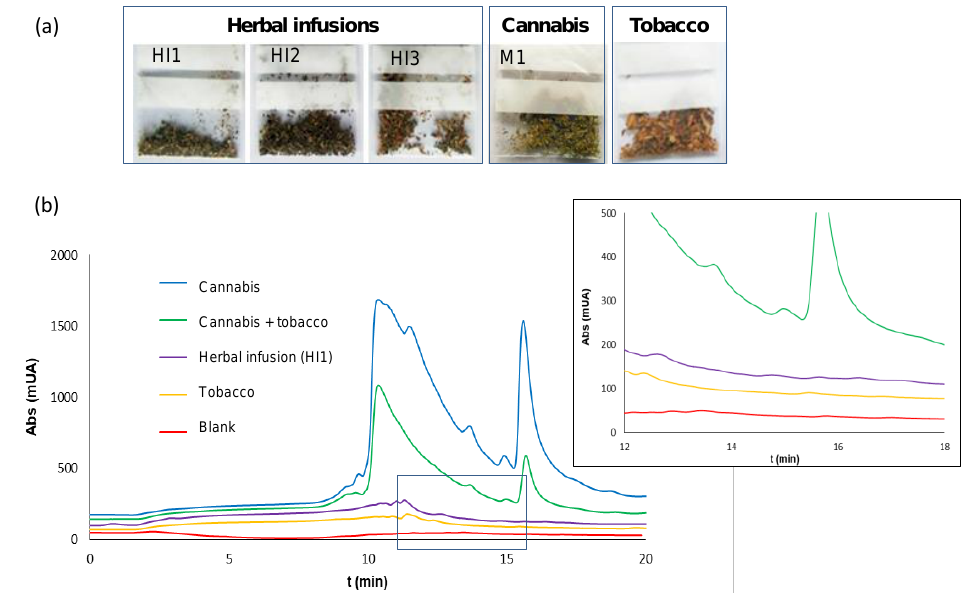
Figure 5. ( a ) Images of the bags with the different products used in the selectivity study: herbal infusions (HI1–HI3), tobacco, and cannabis (M1). ( b ) Chromatograms obtained for the analysis of residues collected from some of the bags ( a ) after the removal of the products: cannabis (M1), tobacco, a mixture of M1 and tobacco (1:4, m/m), herbal infusion (HI1), and a blank. The extracts were diluted 1:20 with ultrapure water before being processed by IT-SPME-nanoLC. Conditions for sampling and extraction were identical to those indicated in Section 2.3.1; conditions used for IT-SPME and chromatographic analysis were identical to those indicated in Sections 4.2 and 4.3, respectively.